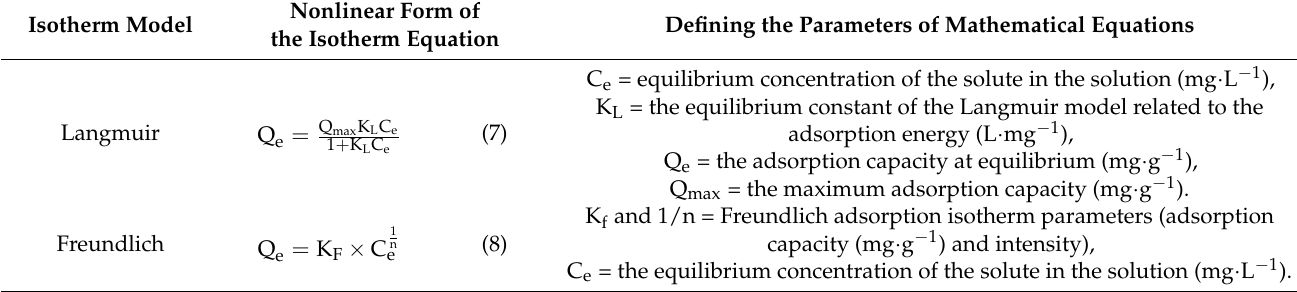
Table 6. The Langmuir and Freundlich nonlinear isotherms.